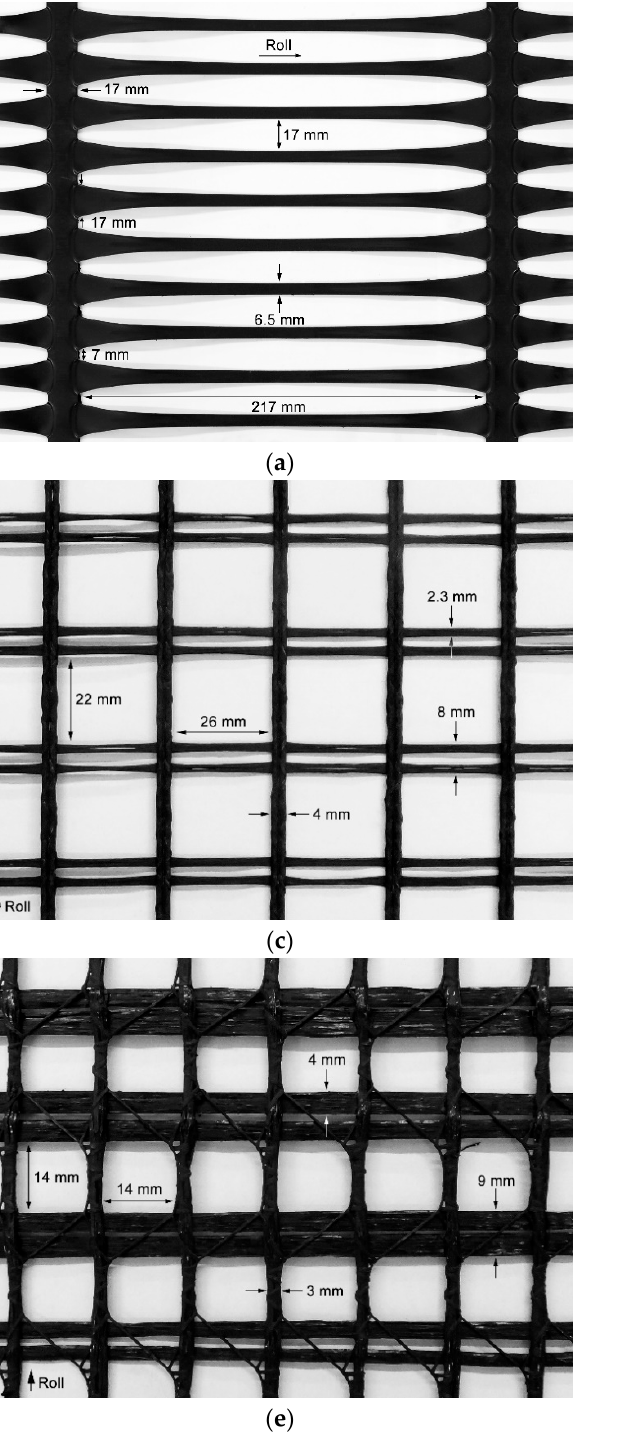
Figure 2. Geogrids: ( a ) overview of extruded geogrid (EG); ( b ) close view of EG; ( c ) overview of woven geogrid I (WG-I); ( d ) close view of WG-I; ( e ) overview of woven geogrid II (WG-II); ( f ) close view of side A of WG-II; ( g ) close view of side B of WG-II. (Side A—side with the machine direction ribs standing out; Side B—side with the cross-machine direction ribs standing out).